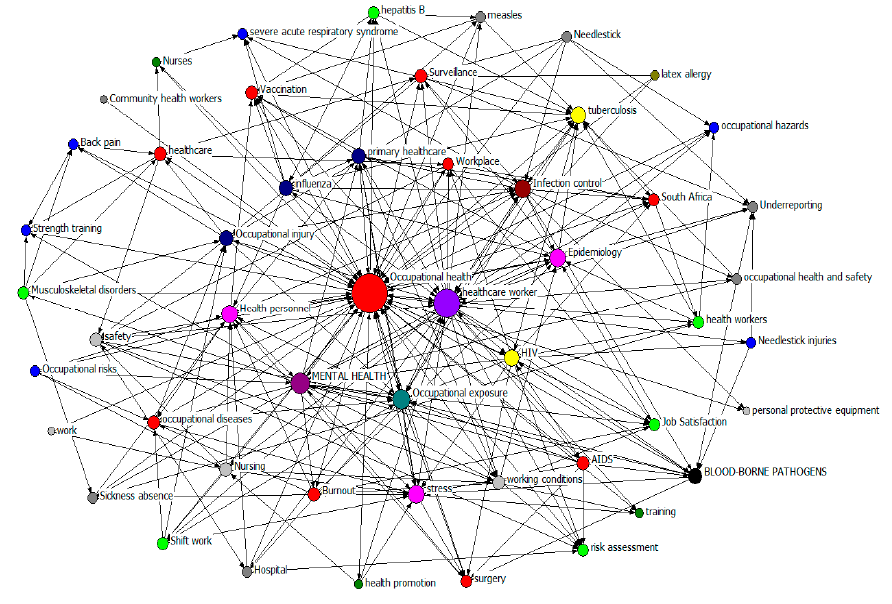
Figure 5. Keyword co-occurrence network of the 51 most frequent keywords by degree.